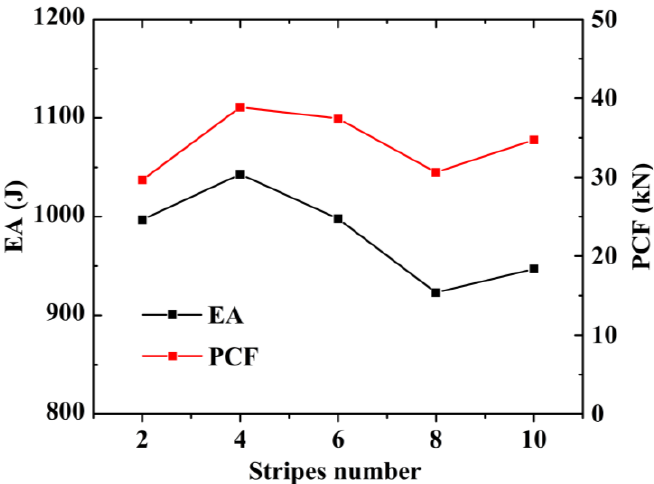
Figure 14. Effect of stripes on energy absorption and